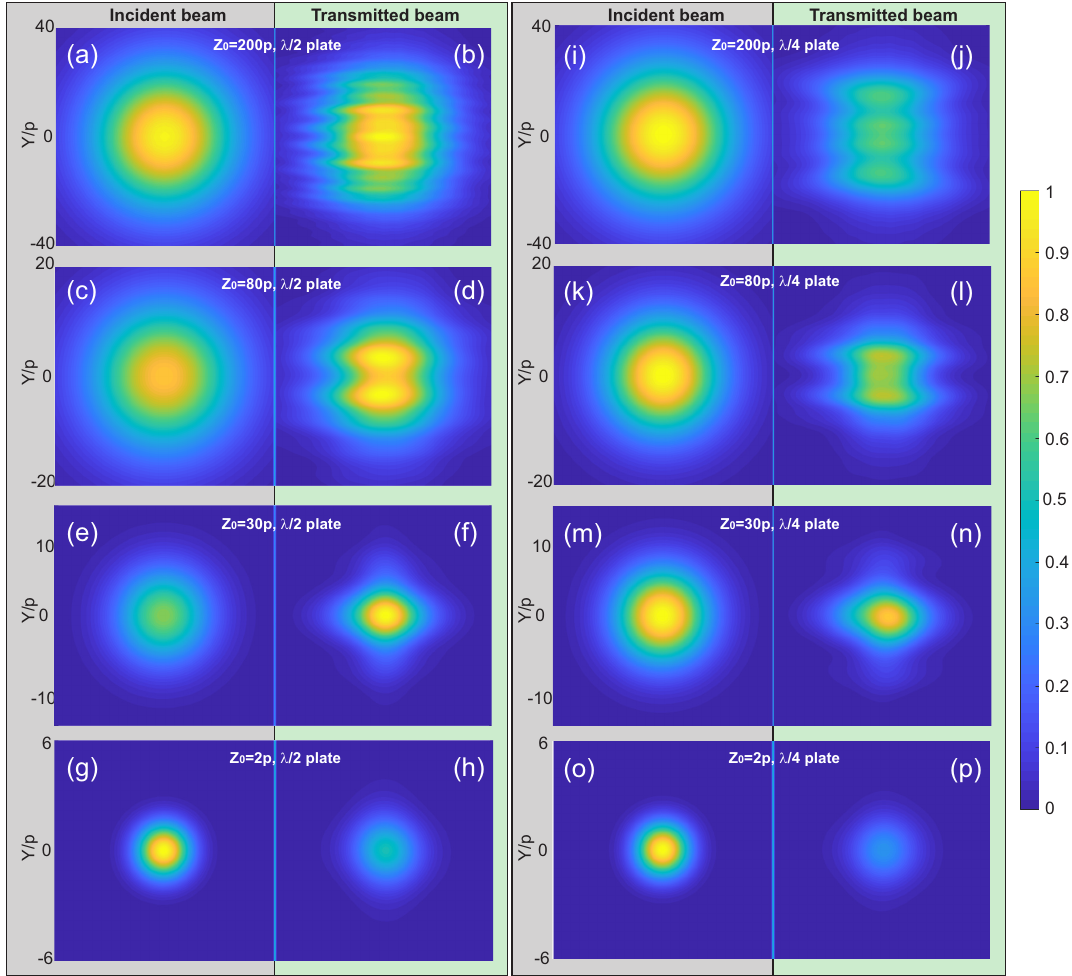
Figure 5. Incident ( a ) and transmitted electric field intensities in a transversal plane located at Z 0 = 30 p from the anisotropic metasurface in the case of λ /2 ( b ) and λ /4 ( c ) plates. Figures ( a , b ) to ( g , h ) refer to the λ /2 plate while figures ( i , j ) to ( o , p ) are attributed to the λ /4 plate. The total dimension of each figure is 32 p × 32 p . The waist of the beam is located at Z 0 = 0, and its value is fixed to W 0 = 2 p